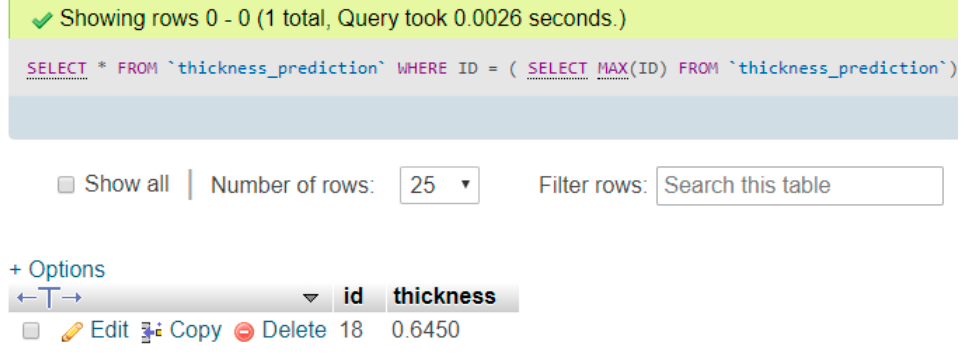
Figure 15. The python script results.